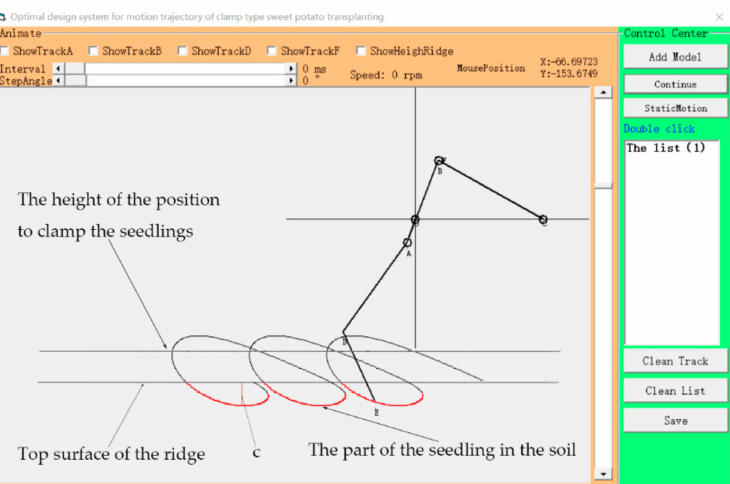
Figure 6. The part of seedling’s stalk in the soil.